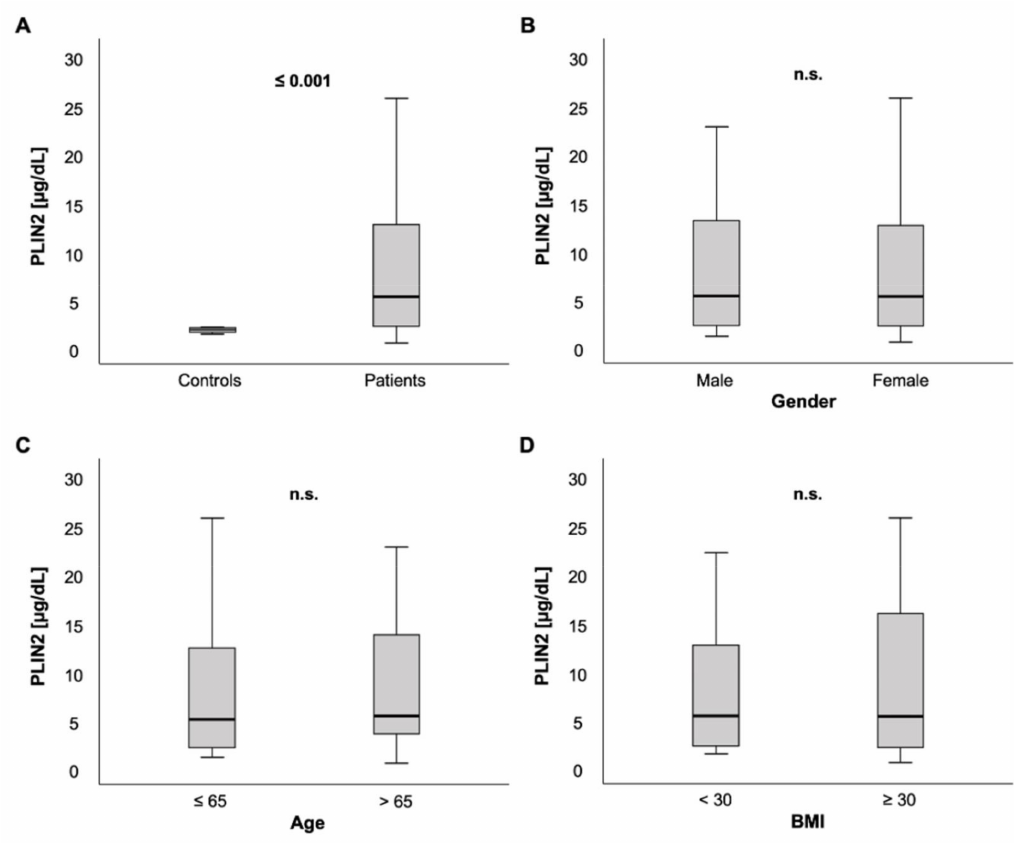
Figure 1. PLIN2 serum concentrations in critically ill patients at intensive care unit (ICU) admission. ( A ) Critically ill patients on the ICU had elevated PLIN2 serum levels compared to healthy controls. ( B – D ) No difference of PLIN2 serum concentrations was seen between male and female ICU patients ( B ), ICU patients ≤ 65 vs. > 65 years ( C ) or ICU patients with a body mass index (BMI) < 30 vs. ≥ 30 kg/m 2 ( D